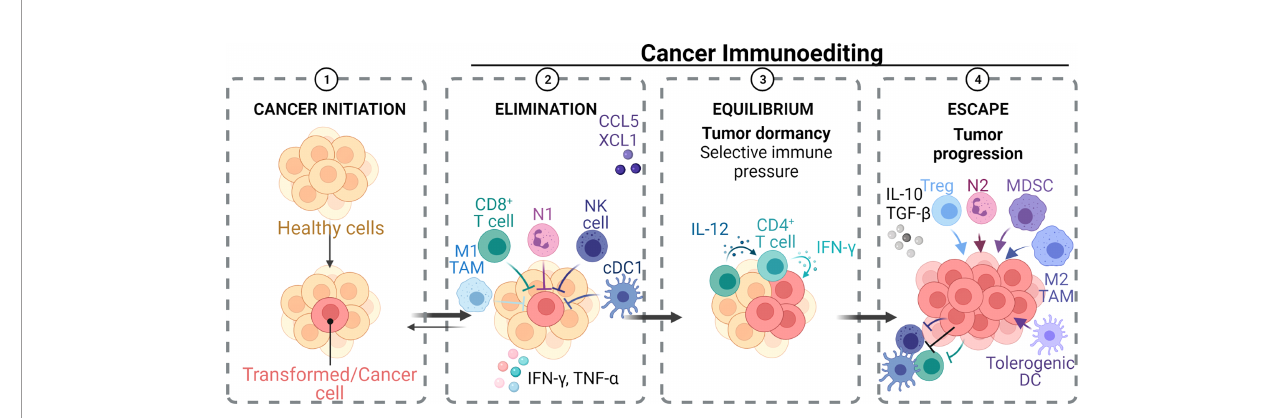
FIGURE 6 | Immunoediting during tumorigenesis. 1. Initiation of cancer with transformation of healthy cells. 2. Robust response from innate and adaptive immune cells such as N1 neutrophils, CD8 + T, M1 TAM, NK, and cDC1, producing key cytokines IFN g and TNF a to eliminate the cancer cells. 3. Equilibrium between the immune cell response and cancer growth in the presence of proin fl ammatory cytokines. Overtime, more resistant tumor variants arise that can evade the immune response and escape. 4. Tumor growth and progression in the presence of immune suppressive cells such as Tregs, N2 neutrophils, MDSCs, M2 TAMs, and tolerogenic DCs, producing key anti-in fl ammatory cytokines 1L-10 and TGF- b . Anti-tumor immune cells are suppressed in this highly tumoricidal